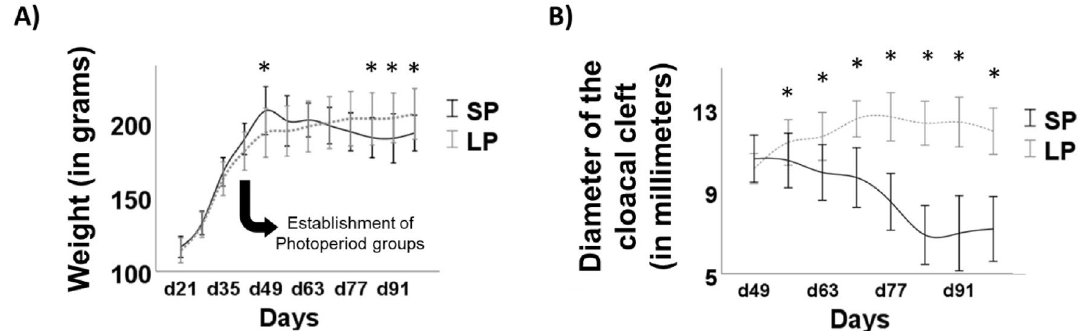
Figure 3. Effect of photoperiod in quail anatomical parameters. ( A ) Weight (in grams) of quail exposed to short (SP) and long (LP) photoperiod conditions. ( B ) Diameter of the cloacal cleft (in millimeters) for SP and LP birds. * p < 0.05, significant difference between short-photoperiod exposed birds and long-photoperiod exposed birds. Data are presented as mean ±